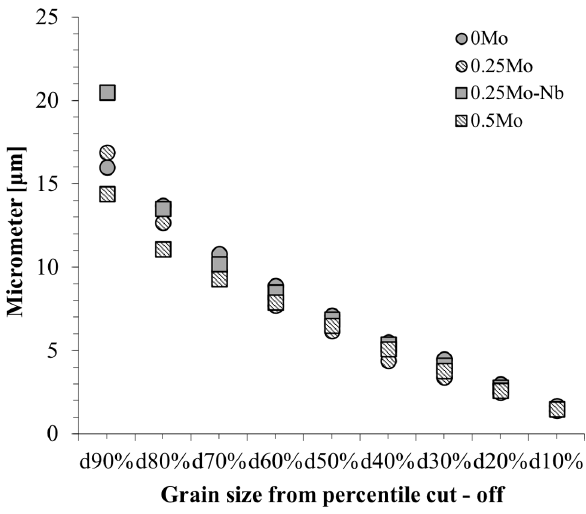
Figure 5. Results of the electron backscatter diffraction (EBSD) analysis in the as-quenched condition (FRT 900 °C). ( a ) Mean effective equivalent circle diameter (ECD) grain and lath sizes, and the ECD size of the coarsest grains ( d 90%), ( b ) grain boundary misorientation distributions (>2.5°).